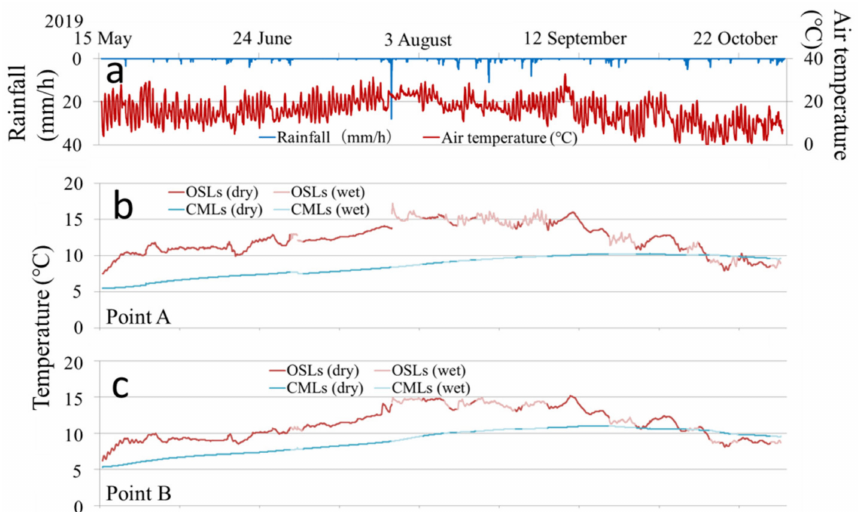
Figure 7. ( a ) Rainfall and air temperature and groundwater temperature at ( b ) Point A and ( c ) Point B.